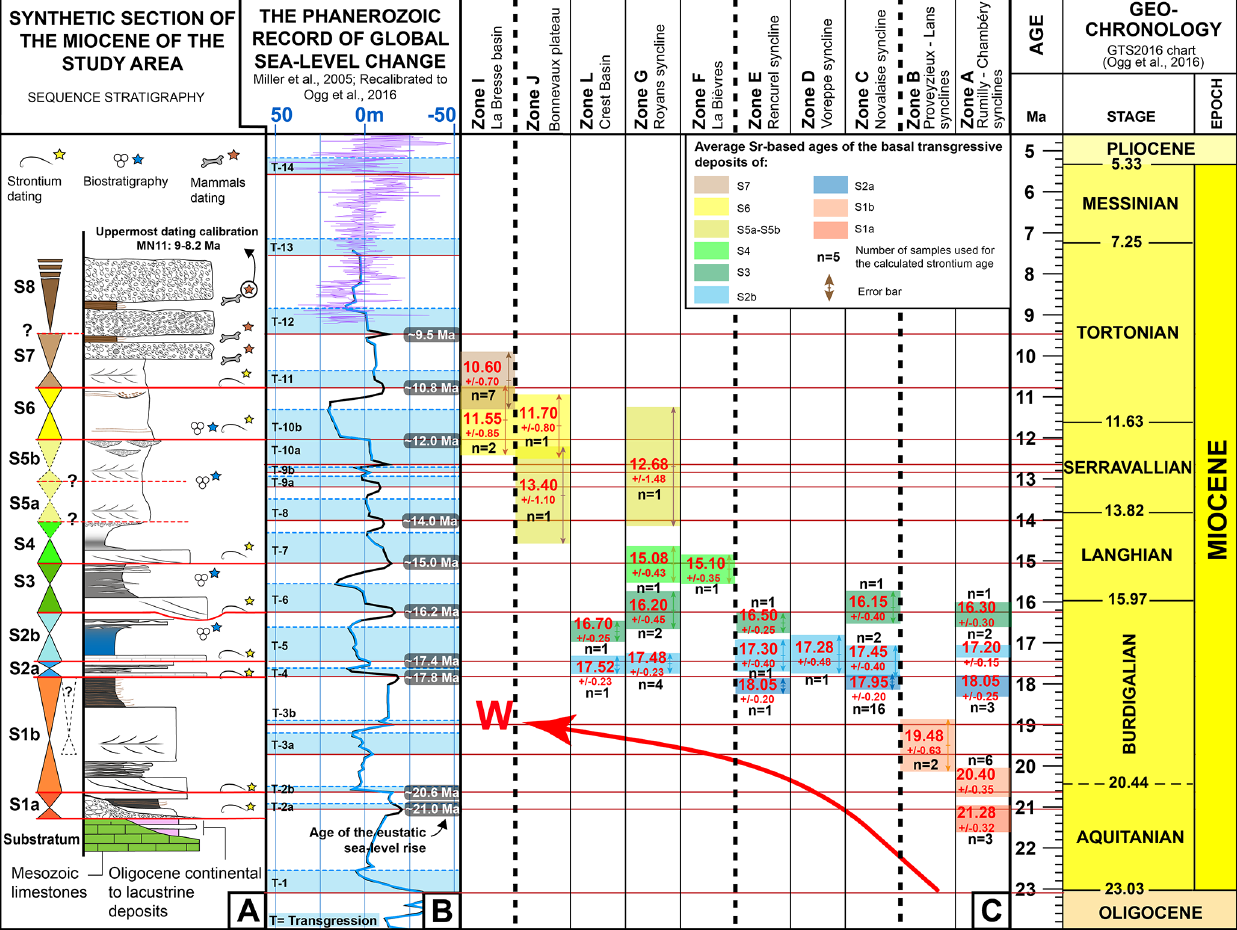
Figure 4. The Miocene chronostratigraphy of the subalpine massifs, southern Jura, and adjacent basins (Bas-Dauphiné, La Bresse, Crest). (A) Synthetic section of the Miocene of the study area and the 11 Miocene depositional sequences. Legend in Fig. 5. (B) The eustatic curve of Miller et al. (2005) recalibrated with the global timescale (GTS) of Ogg et al. (2016); (C) average Sr-based ages of the transgressions in the paleogeographical zones. n : number of age values. Only ages of samples with δ 13 C values > − 1‰ (Table S2) are considered here (maximum confidence zone). Red curved arrow: westward migration of the marine deposits during the lower